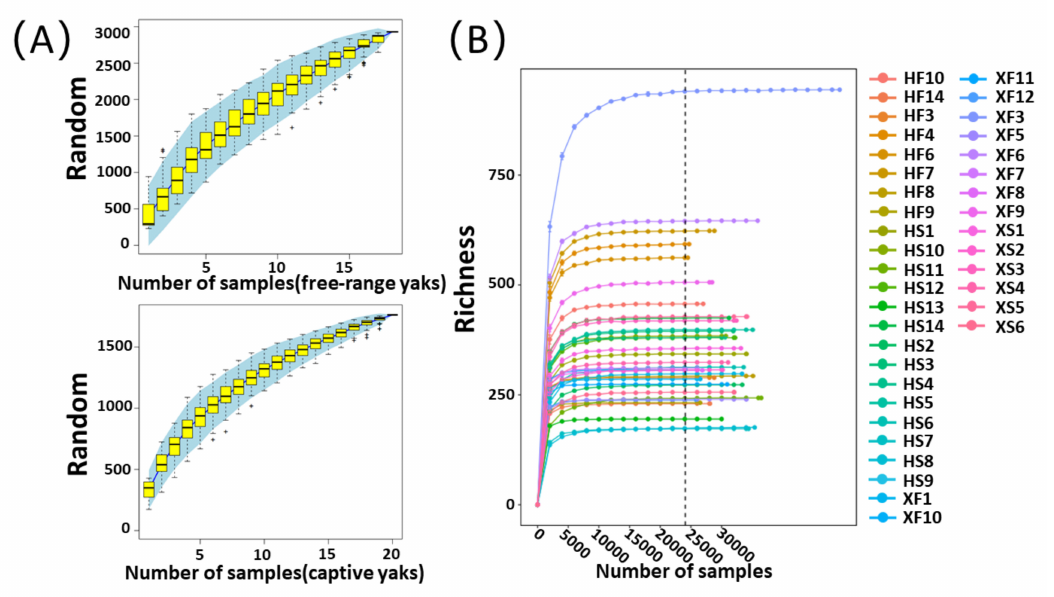
Figure 1. Species accumulation and dilution curves for all samples: ( A ) species accumulation curves of free-range and captive yak samples; ( B ) rarefaction curves of all samples. The legend is the number of all